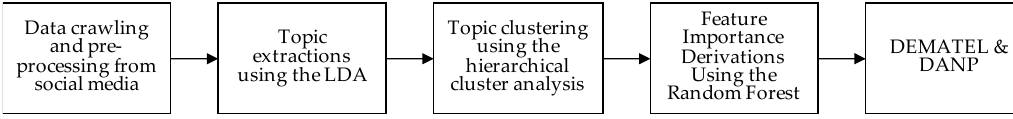
Figure 1. Research Framework.